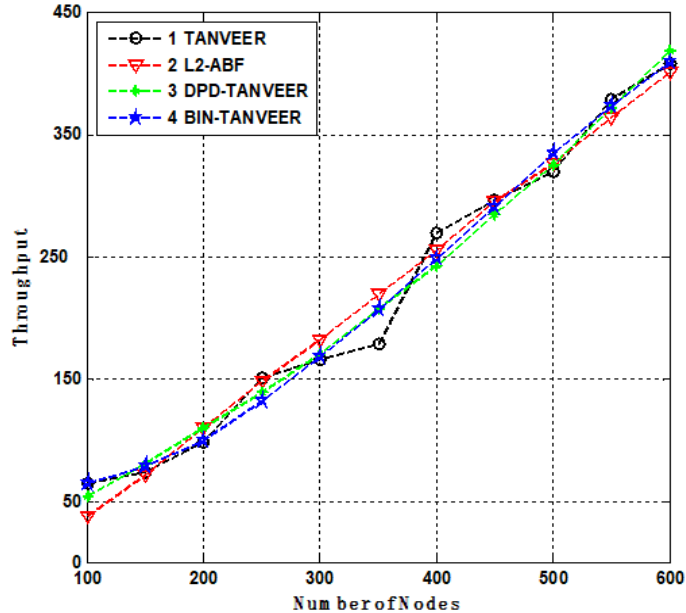
Figure 15. Throughput Analysis of